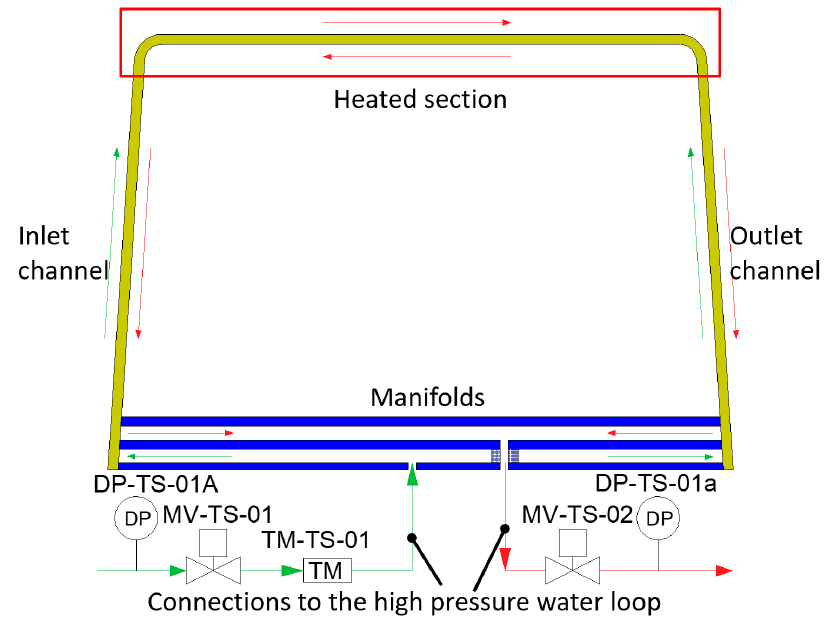
Figure 3. Schematic view of the CHF test section.